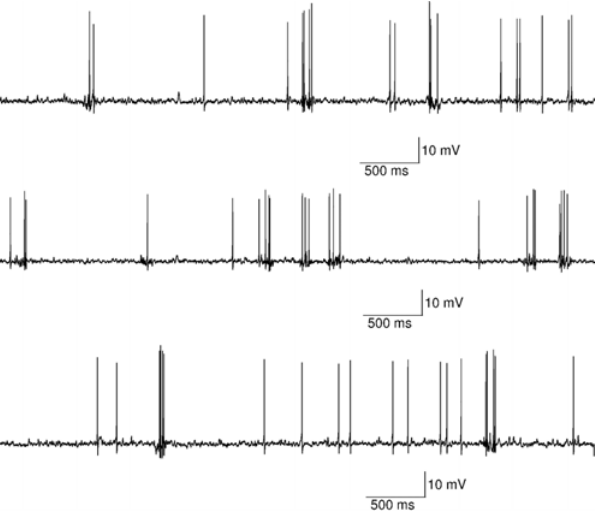
Figure 5. Dynamic behavior of the stochastic granule cell model simulated for a longer duration (15 seconds). A small depolarizing current below firing threshold is applied throughout the simulation, similarly as in Figure 4. Bursts and occasional spontaneous firing can be observed. Bursts are evoked by random changes of s between the values s =0.3 and s =1.1 (during a burst the value of parameter s is increased to 1.1 otherwise it being 0.3). This 15-second simulation also provides evidence that stable solutions are obtained when bursts are evoked.